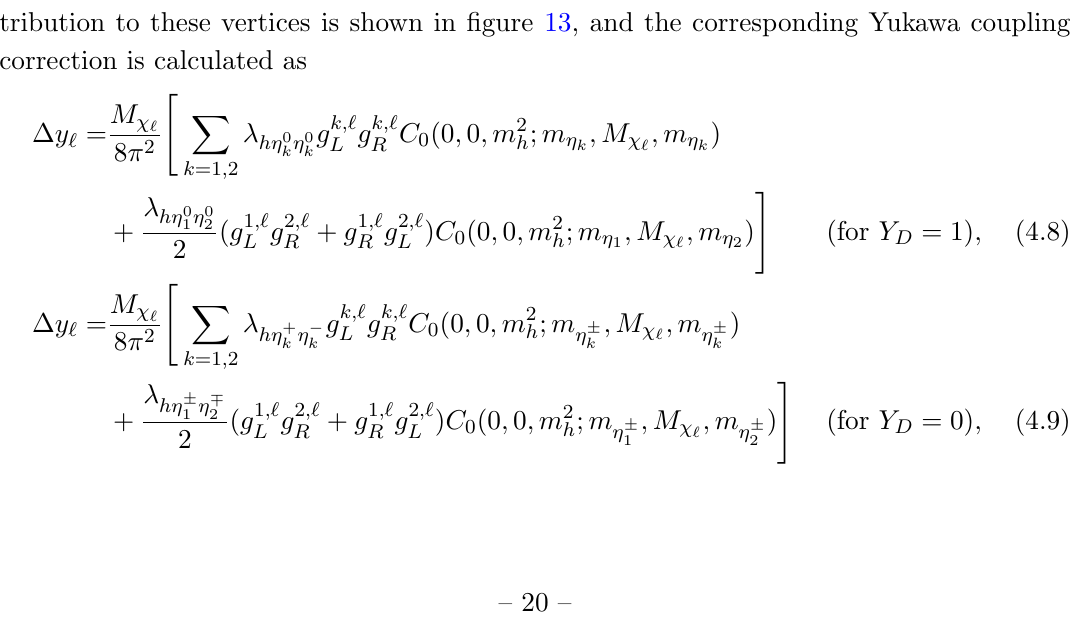
Figure 13 . New physics contributions to the h‘ + ‘ (cid:0) ( ‘ = e; (cid:22) ) vertex in the model with Y (left) and Y D = 0